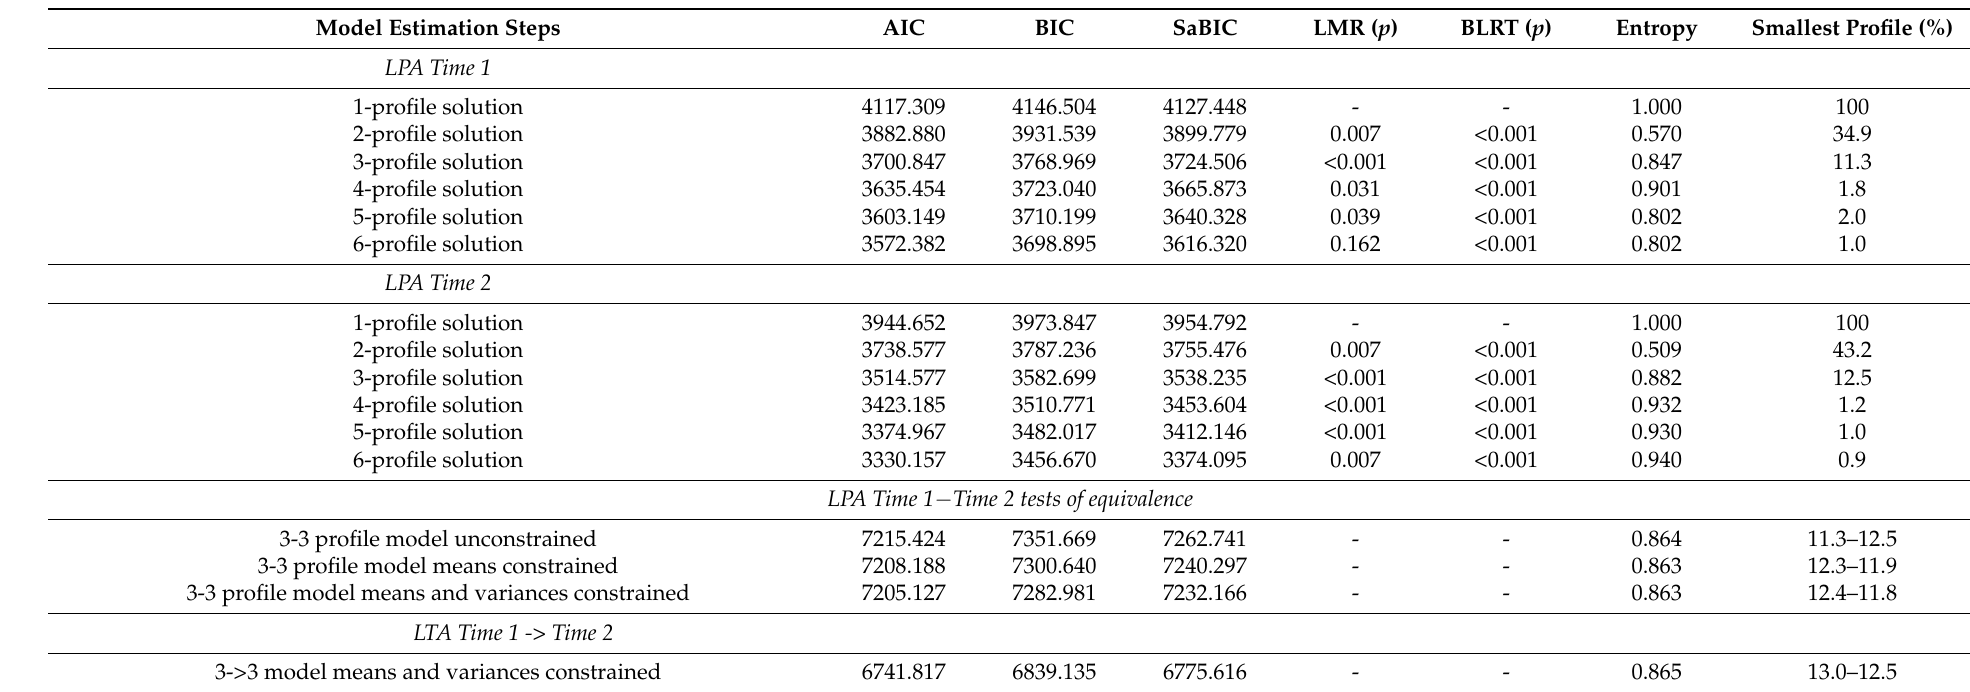
Table 2. Latent profile solutions and their fit